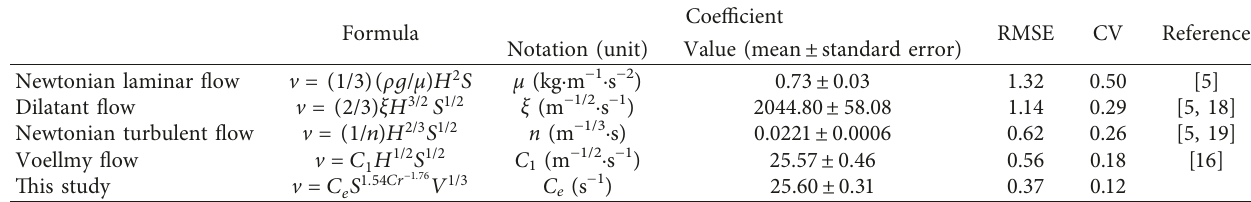
Table 3: Summary of the result of the comparison of velocity estimation models.